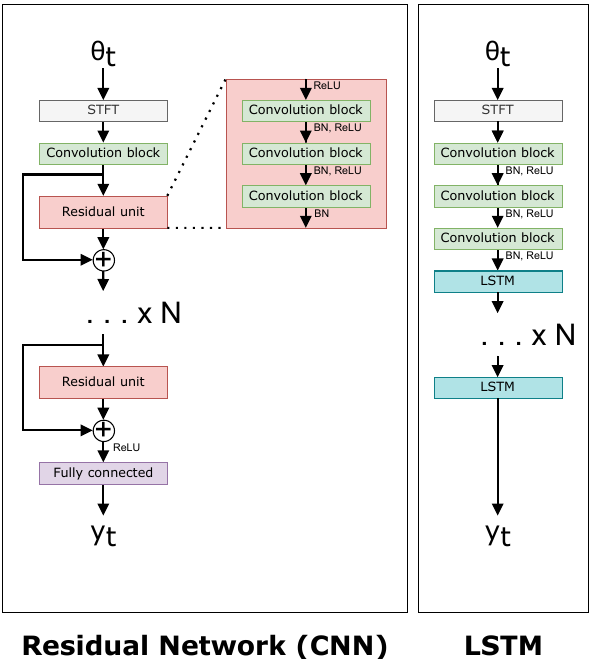
Figure 9. Network architectures for the CNN ( left ) and LSTM ( right